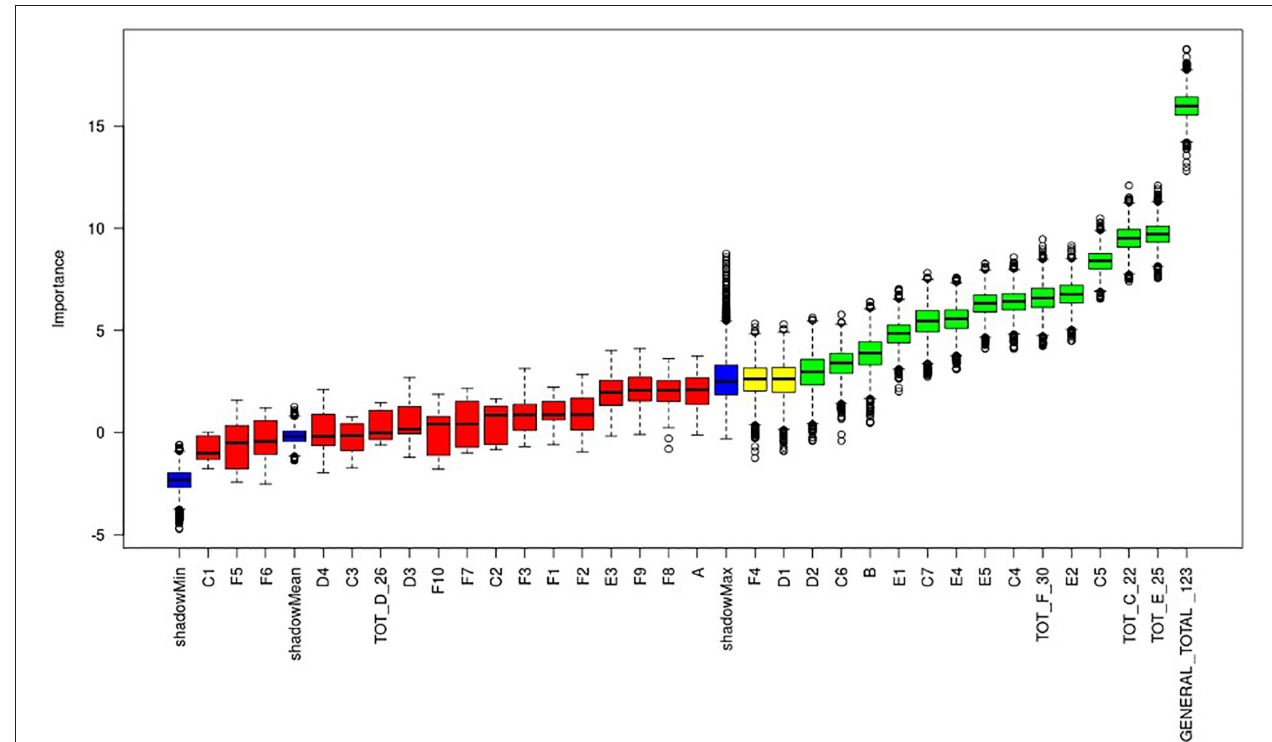
FIGURE 1 | Plot of Boruta feature selection process for the “anesthesia” outcome: the red boxes represent the not relevant items, the yellow are the uncertain ones, the green are the relevant items. Blue boxes are calculated as reference levels during the run of Boruta algorithm.